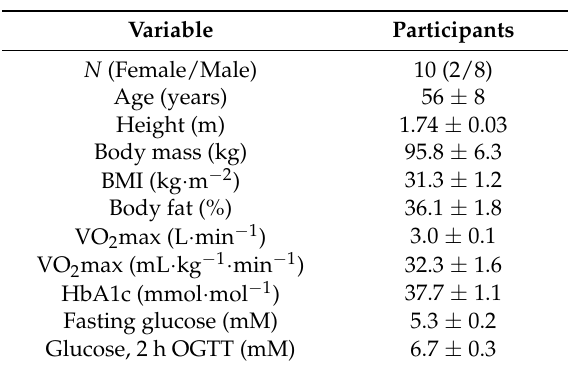
Table 1. Subject